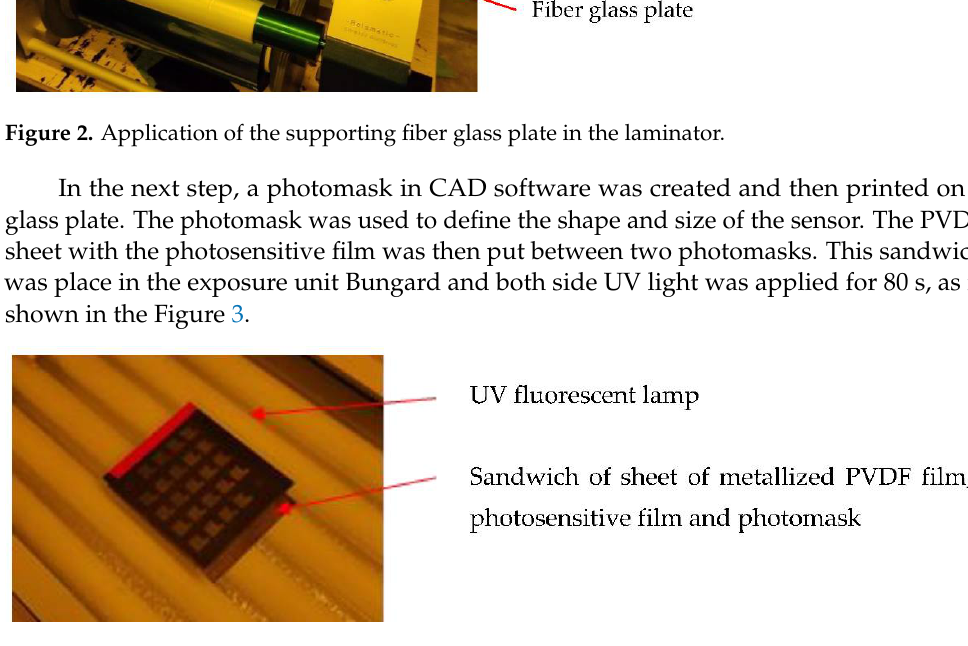
late glue (Loctite Super Attak Power Flex Gel). The thickness of the glue layer is approxi- mately 5 μm. Rivets were covered by an epoxy glue (BISON Epoxy 5 min). The PVDF sensor in its final form mounted on a stainless steel plate is in the Figure 5. Figure 5. PVDF sensor mounted on stainless steel plate. 3. Testing Methods of PVDF Sensors The testing of home-made PVDF sensors was conducted by the ball drop method, which is commonly used for the calibration of impact transducers [11]. The testing method is illustrated in the Figure 6. A stainless-steel ball of a certain weight (cid:1865) drops down ver- tically from initial position 1, hits the calibrated sensor and rebounds to position 2. Initial and final ball positions ℎ (cid:2869) and ℎ (cid:2870) are read on a scale of rule recorded by camera during each test. A glass tube is used for the ball guiding. During the ball impact, a part of the initial ball energy is transformed into a deformation of sensor. The sensor generates an electric charge which is directly measured as an electric voltage output. The maximum voltage (cid:1847) (cid:3040)(cid:3028)(cid:3051) and the time duration of the impact (cid:2028) are determined from the measured signal.